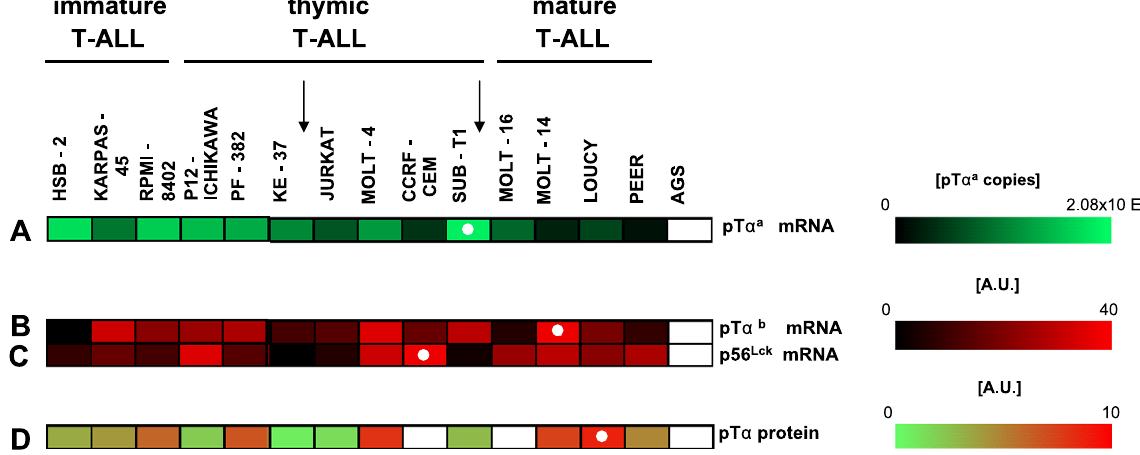
Fig. 1. Expression patterns in T-ALL cell lines for pT α a -, pT α b -, p56 Lck -mRNA and pT α protein. Heat map illustrations are shown with respect to the maturational stage of the particular leukemia cell line. (A) β -actin normalized pT α a (wildtype) mRNA expression analyzed by RT-qPCR in human T-ALL cell lines (absolute quantification in copy numbers of pT α a ). (B) β -actin normalized pT α b (truncated isoform) and (C) p56 Lck mRNA expression by RT-PCR (relative quantification in arbitrary units; A.U.). (D) Actin normalized pT α protein expression analyzed by Western blotting (relative quantification in arbitrary units; A.U.). Cell lines with the highest expression are marked by white circles. White squares indicate negative control (AGS – gastric cancer cell line), or cell lines in which protein analysis was not performed (e.g., CCRF-CEM and MOLT-16). Arrows indicate the developmental stage with expected pT α